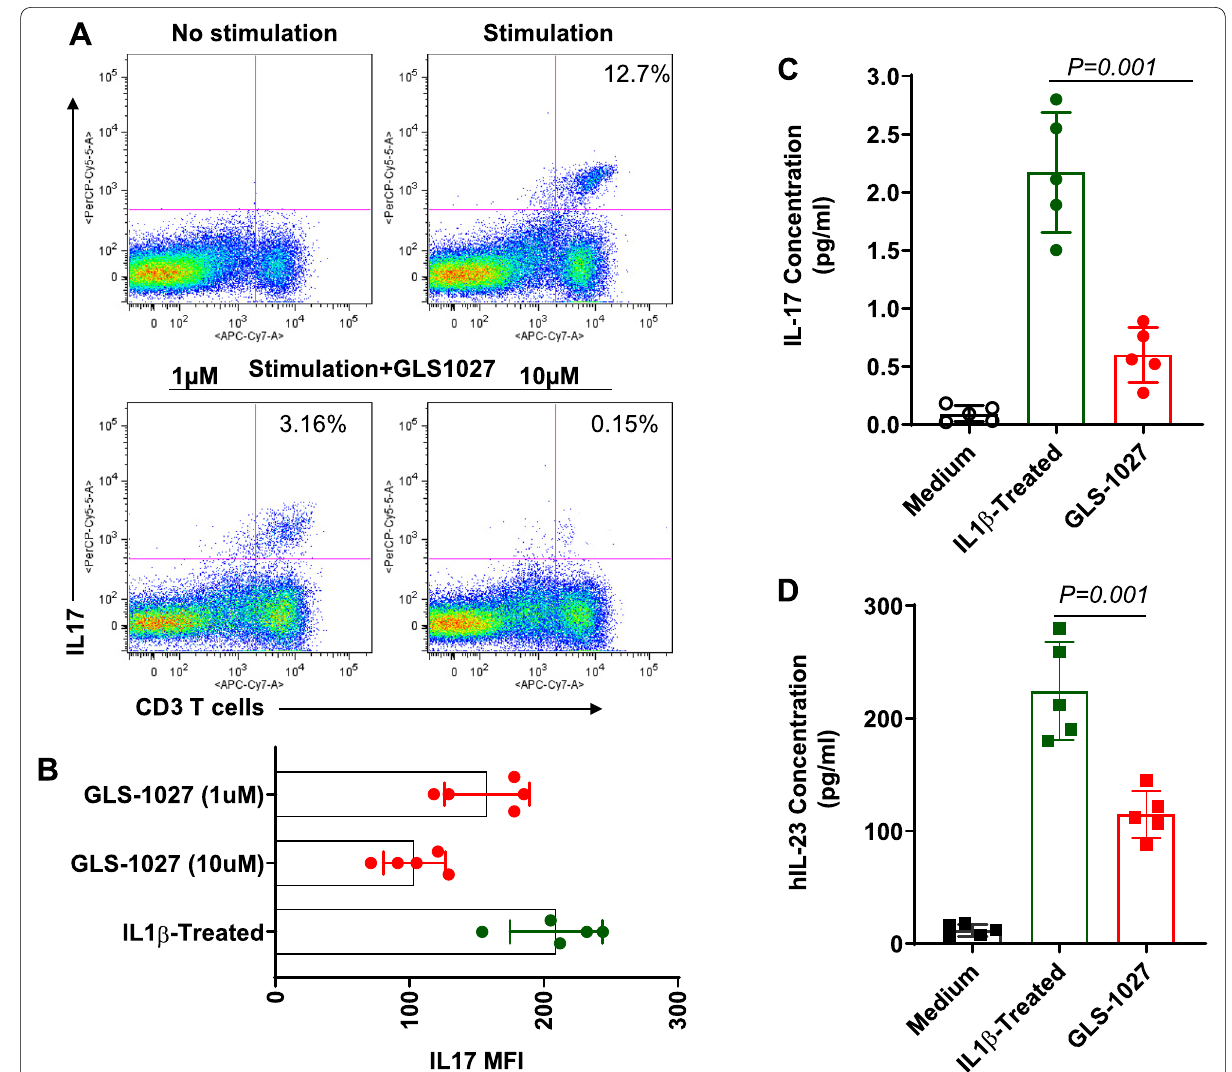
Fig. 4 GLS-1027 prevents the development of Th17 T cells. Purified, naïve human CD3 T cells from peripheral blood mononuclear cells (PBMC) by depleting B cells, NK cells, monocytes, platelets, dendritic cells, granulocytes, and erythrocytes. Isolated CD3 + T cells were bead- and antibody-free and incubated with 10 U/ml of IL-2, 10 ng/ml of IL-1β, 10 ng/ml of IL-23, 1ug/ml of anti-IL-4, 1ug/ml of anti-IFN-γ and anti-CD3/CD28 activation beads at a ratio of 1 bead per cell plus IL1-β 10ng/ml. In some cultures, GLS-1027 was added at a concentration of 1µM or 10µM at the same time as the Th17-inducing cytokines. ( A ) On day 6, the cells were stained with antibodies to CD4 and intracellular IL-17A and then evaluated by flow cytometry. Percentage of CD4 + /IL-17 + cells indicated in the upper right quadrant of plots. ( B ) Mean Fluorescent Intensity (MFI) of IL-17 in CD4 + T cells. ( C‑D ) Concentration of IL-17 and IL-23 in media of differentiated CD4. + T cells; GLS-1027 concentration was 10µM. A non-parametric two-tailed t- test (Mann–Whitney) was used for statistical analysis, and the relevant p values are indicated. Error bars in all panels indicate a standard deviation among 3 replicates per condition. The experiment was repeated twice with similar results are shown in this representative